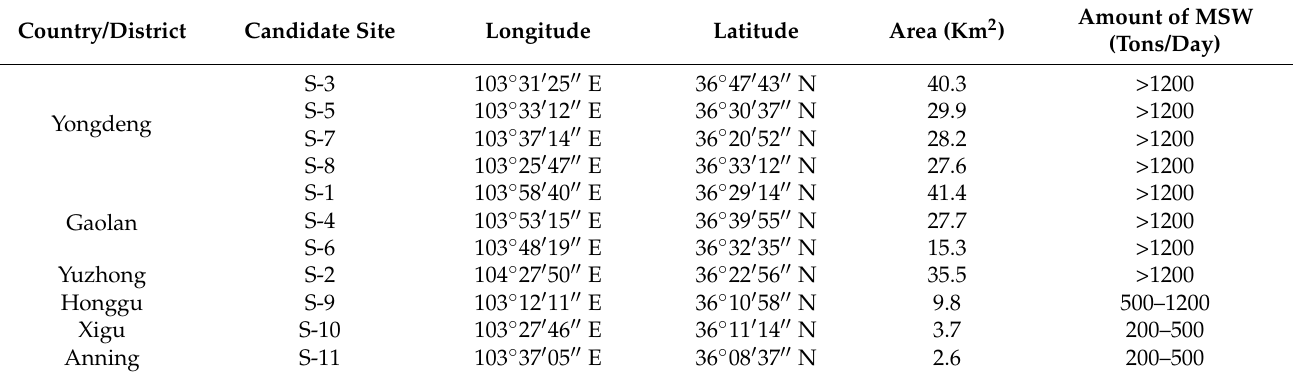
Table 3. Candidate site latitude, longitude, area, and MSW disposal capacity. S-1 and S-2 had the highest MSW disposal capacities, S-4, S-6, and S-10 had the lowest MSW disposal capacities. Country/District